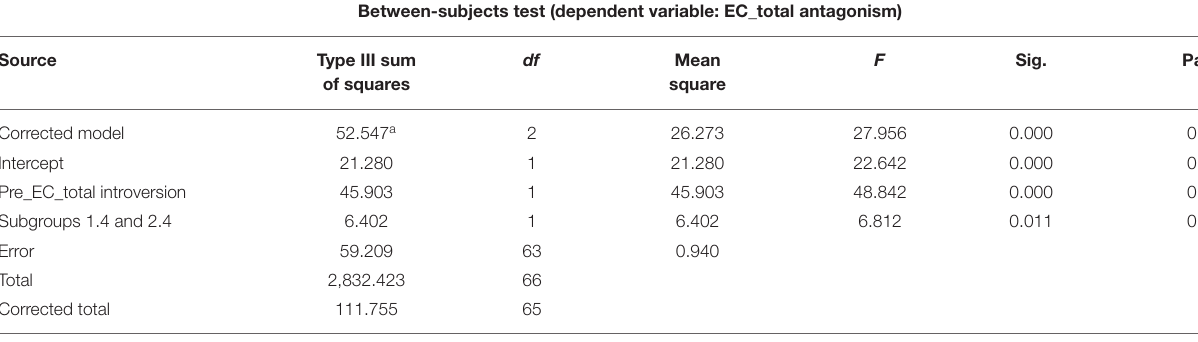
TABLE 5 | ANCOVA results for emotional competences development (ECD): antagonism. Between-subjects test (dependent variable: EC_total antagonism)